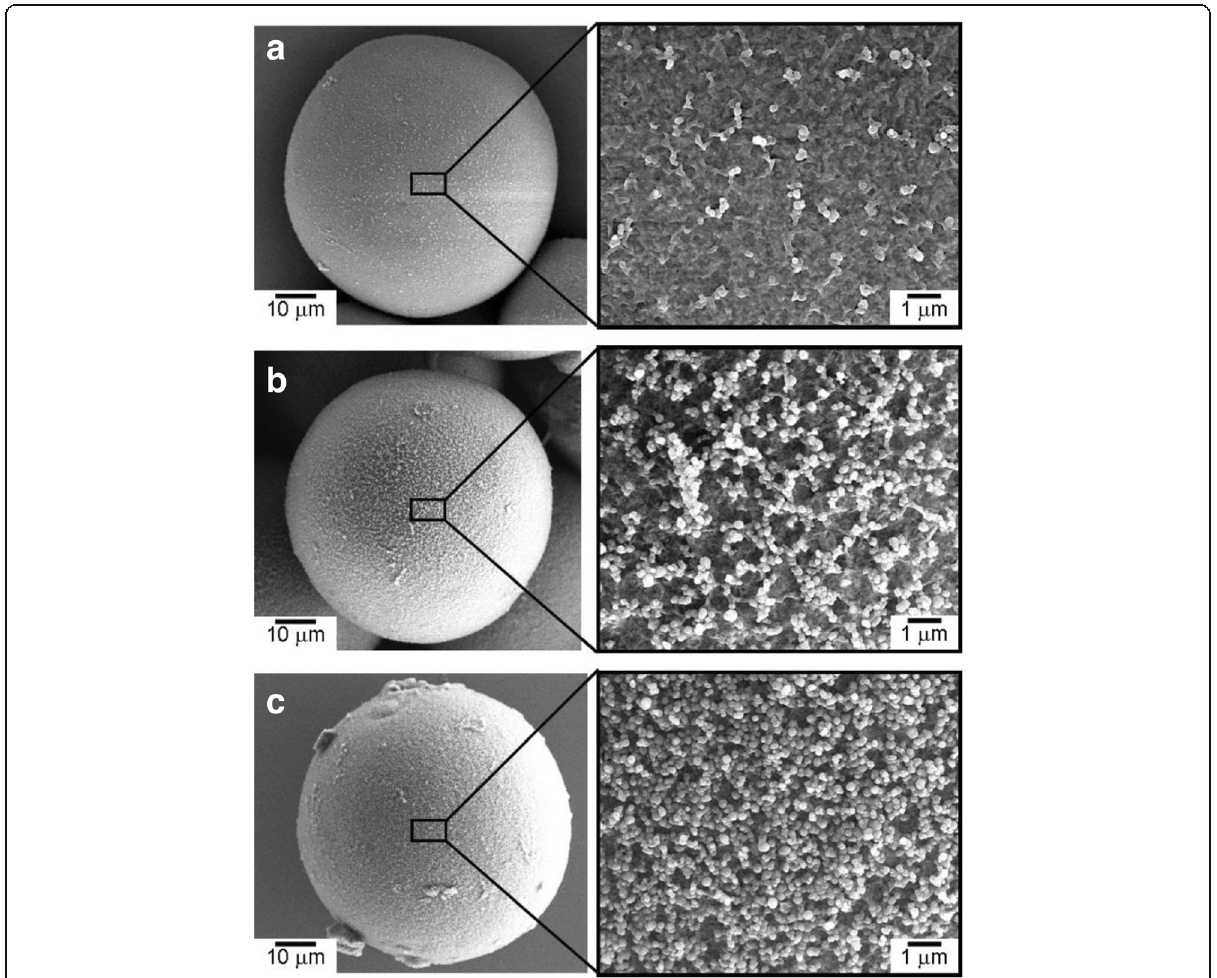
Fig. 2 SEM images of the a 0.3 vol%, b 0.6 vol%, and c 1.0 vol% CNP coated on Al 2 O 3 granulation particle with average diameter of 62 μ